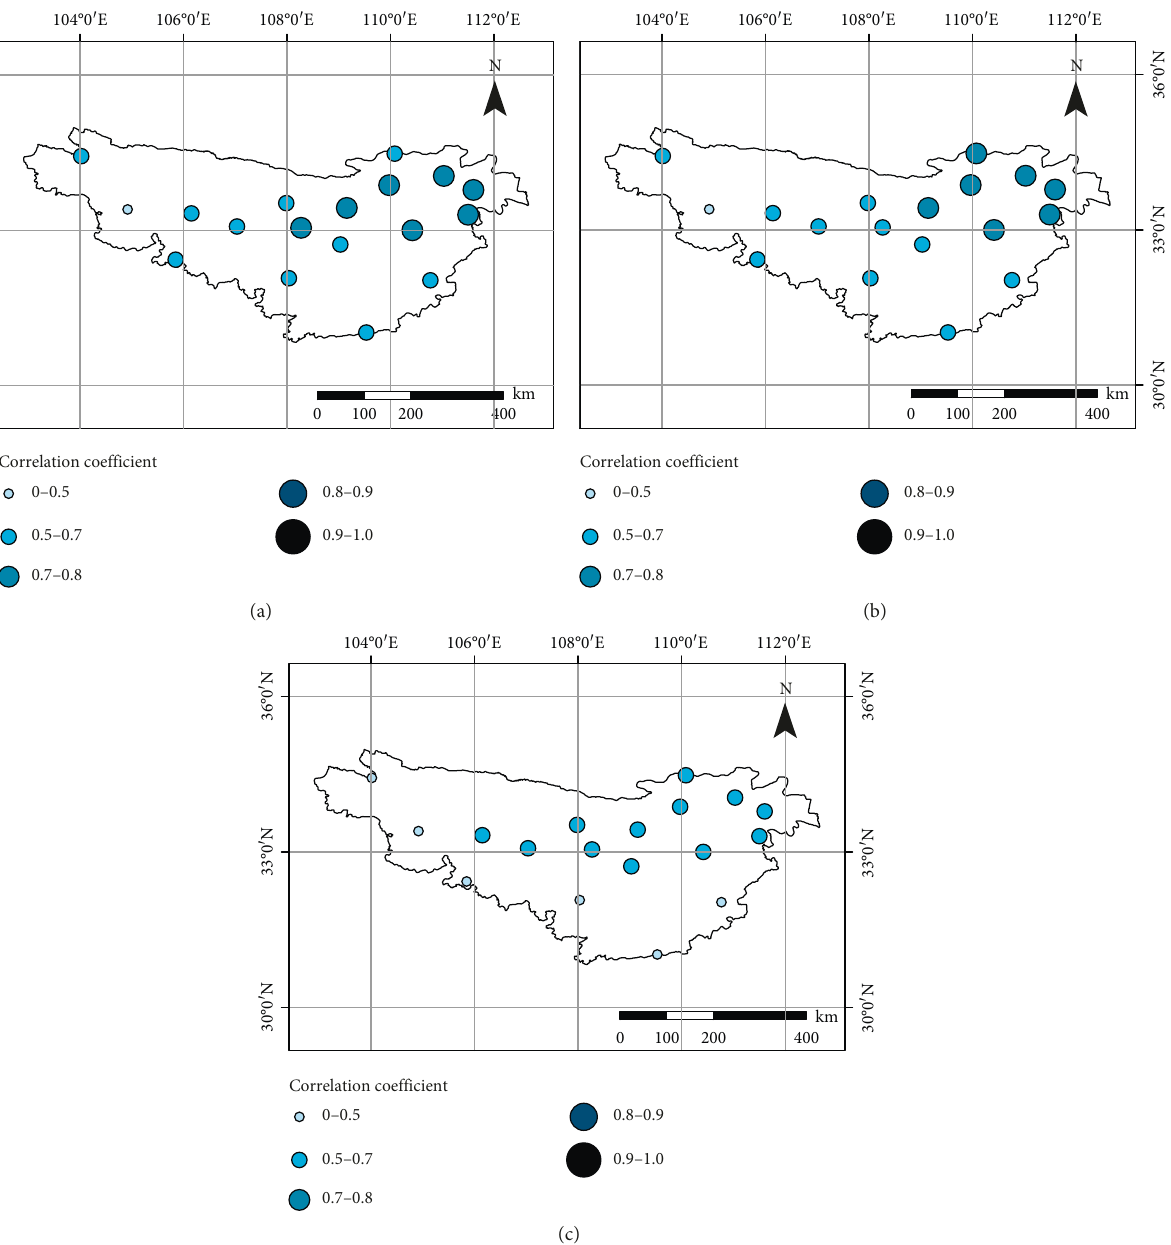
Figure 4: Correlation coefficient at each precipitation gauge stations over the Qinling-Daba Mountains for monthly precipitation between (a) ERA-Interim and gauges, (b) JRA-55 and gauges, and (c) NCEP/NCAR-1 and